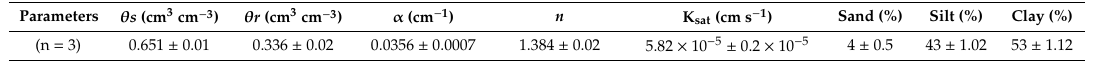
Table 1. Hydrological properties of the bauxite